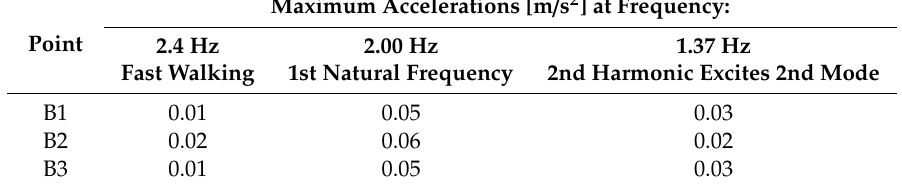
Table 11. Maximum vertical accelerations generated by a single pedestrian walking obtained at the representative points of the beam footbridge with the RC slab the selected frequencies.